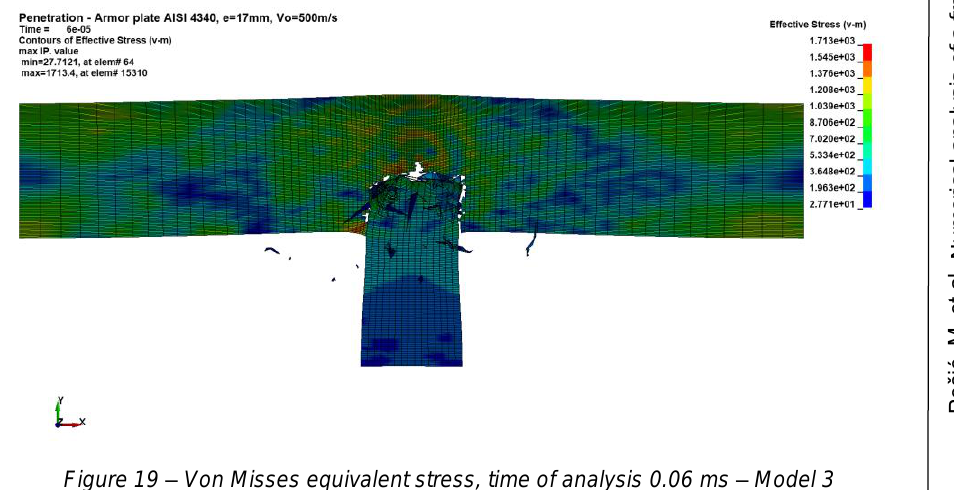
Figure 19 – Von Misses equivalent stress, time of analysis 0.06 ms – Model 3 Рис. 19 – Von Misses эквивалентное напряжение, время анализа 0.06 ms – Модель 3 Слика 19 – Von Misses-ов еквивалентни напон, време анализе 0,06 ms – модел